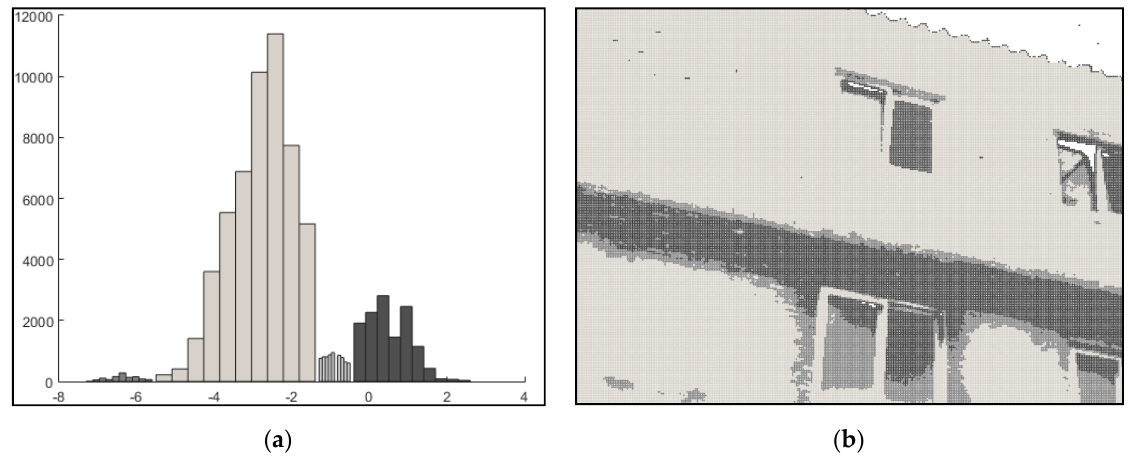
Figure 2. Temperature area clustering based on Gaussian Mixture Model (GMM): ( a ) histogram of temperature and ( b ) clustering result.